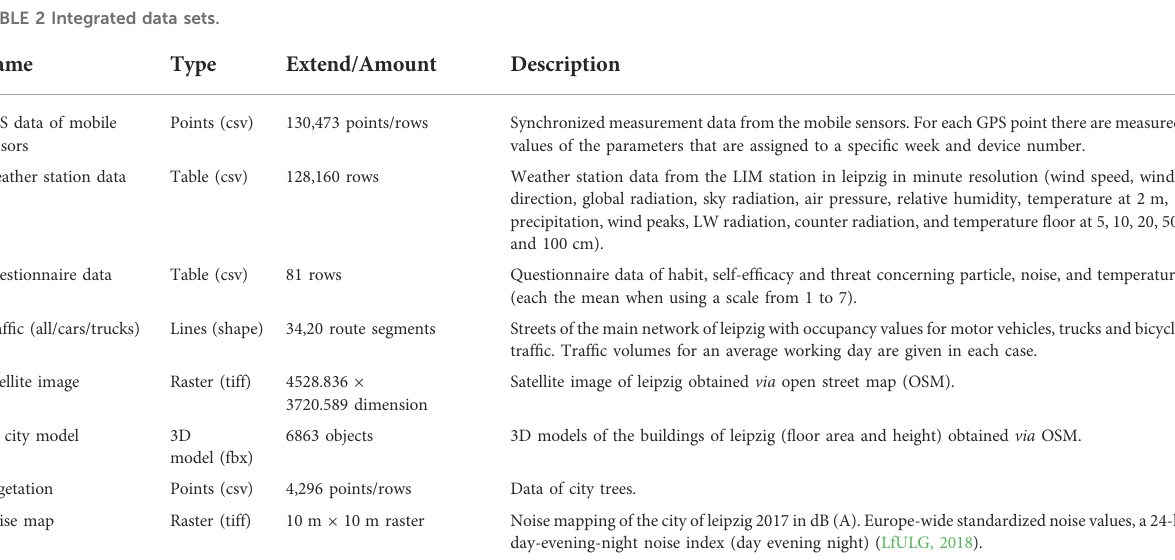
TABLE 2 Integrated data